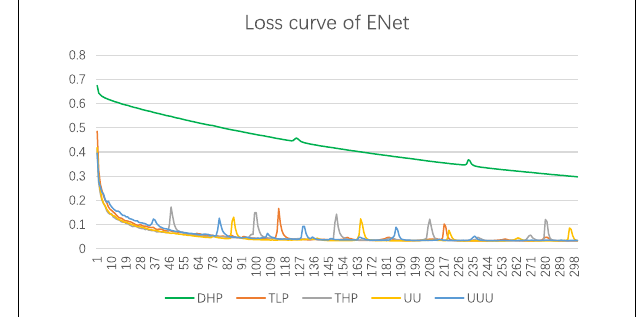
FIGURE 10 | Segmentation loss curve for MPM dataset.